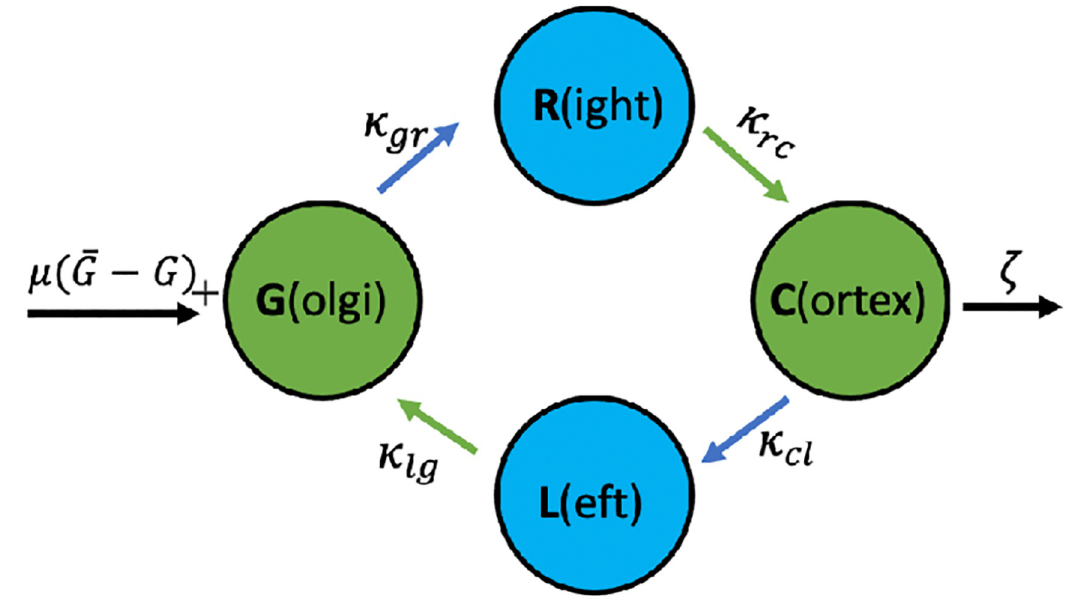
Fig 4. Graphical sketch of the minimal 4-state